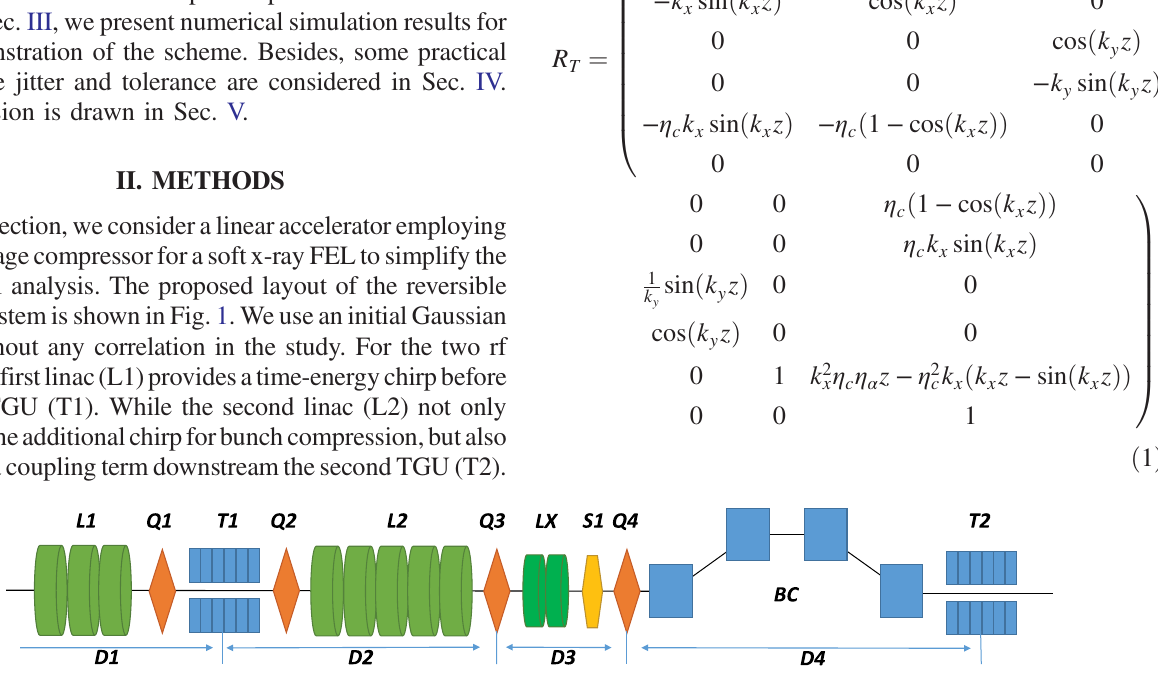
FIG. 1. Layout of the proposed reversible beam heater based on TGUs. The first TGU (T1) is located between the first and the second rf linacs (L1, L2) and the second one (T2) is located downstream of the bunch compressor (BC). The layout also includes several quadrupoles (Q1 — Q4), a harmonic cavity (LX) and a sextupole (S1). According to Eq. (6), D1 — D4 indicate the relative lengths where Q1 and Q2 are switched